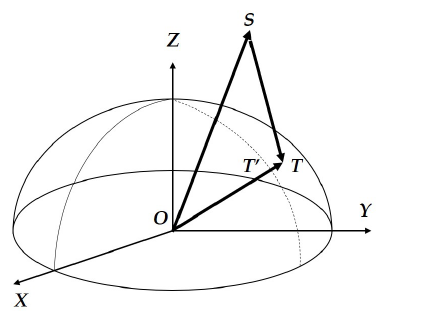
Figure 1. Range-Doppler (RD) imaging model defined in the earth centered rotating (ECR)